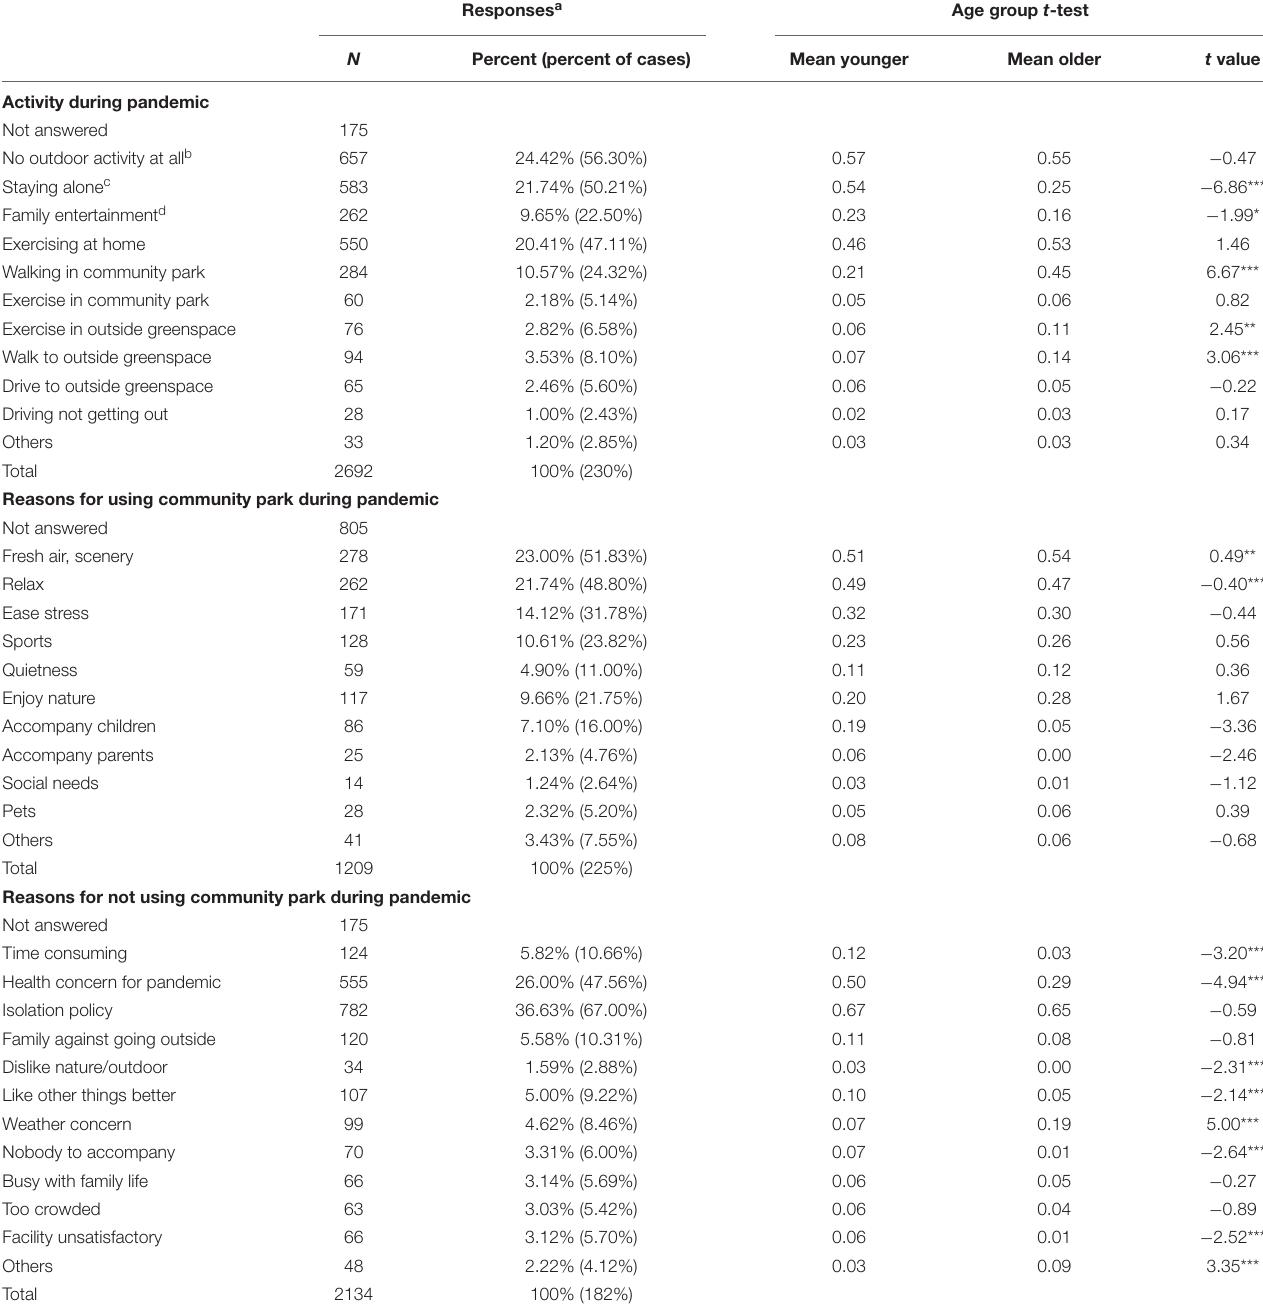
TABLE 2 | Response of multiple